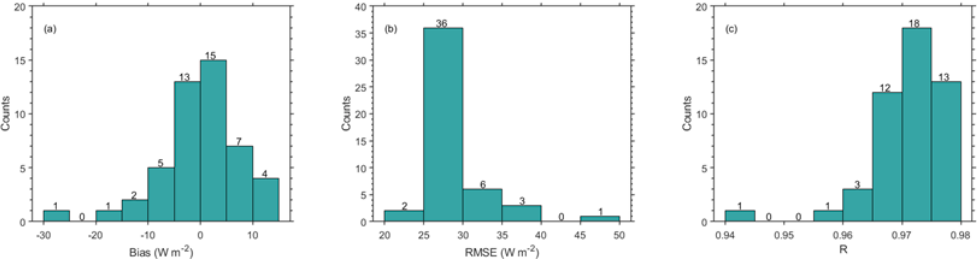
Figure 3. Bias ( a ), root mean squared errors (RMSE) ( a ) and R ( c ) histograms for monthly SSR simulations from 48 GCMs.